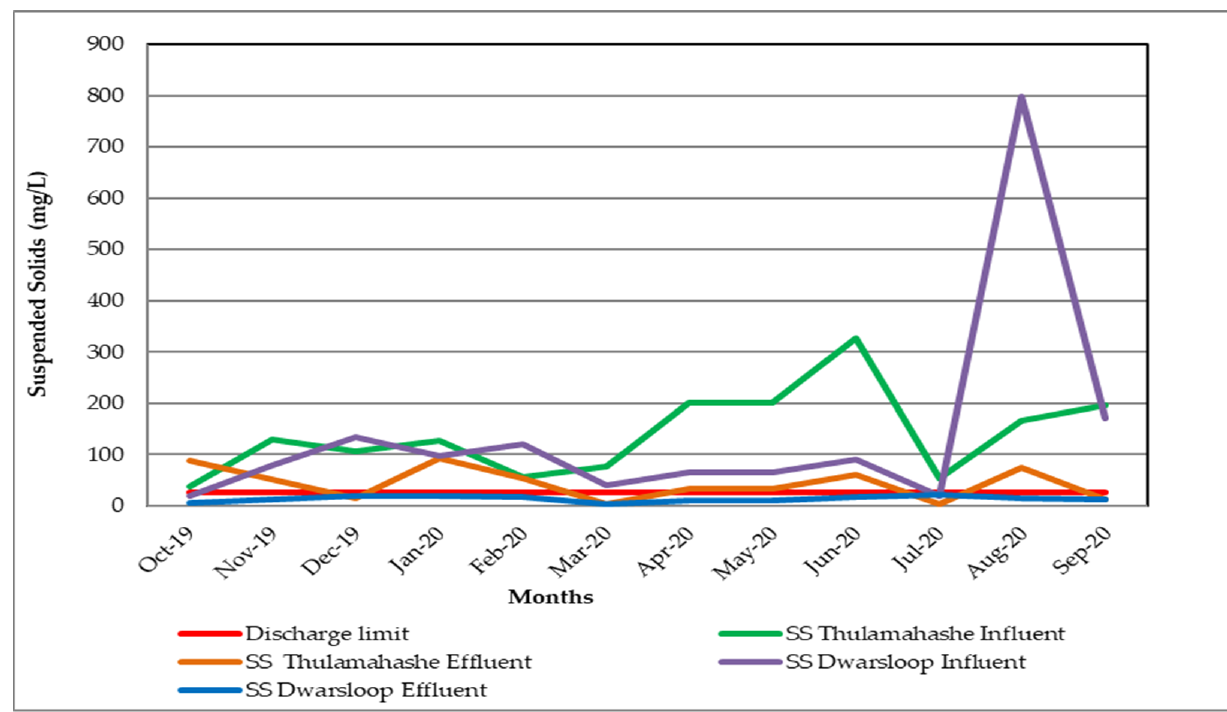
Figure 7. WWTW’s performance in terms of Suspended Solids.